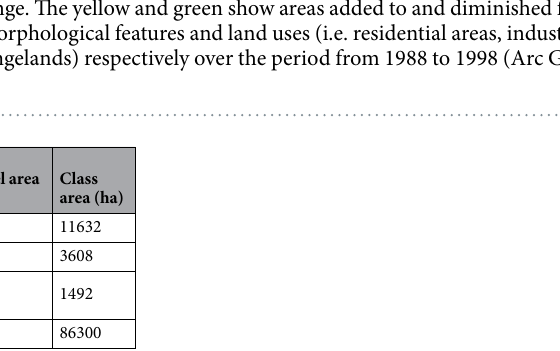
Table 1. The estimated rate of change detection technique for Rigboland sand sea.